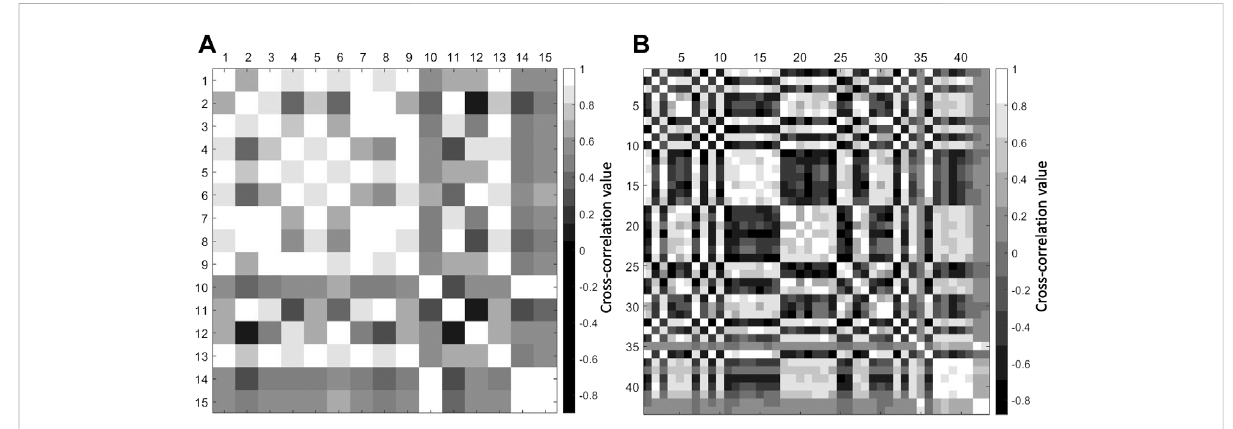
FIGURE 3 Cross-correlationmatricesfor (A) VLPand (B) ULPiterations.Thematricesare15×15and43×43wide,respectively:thefamiliesfoundbytheCC algorithm are reported on the x- and y -axes, while the blocks have a color associated with the mutual cross-correlation value. Lighter colors represent a higher degree of